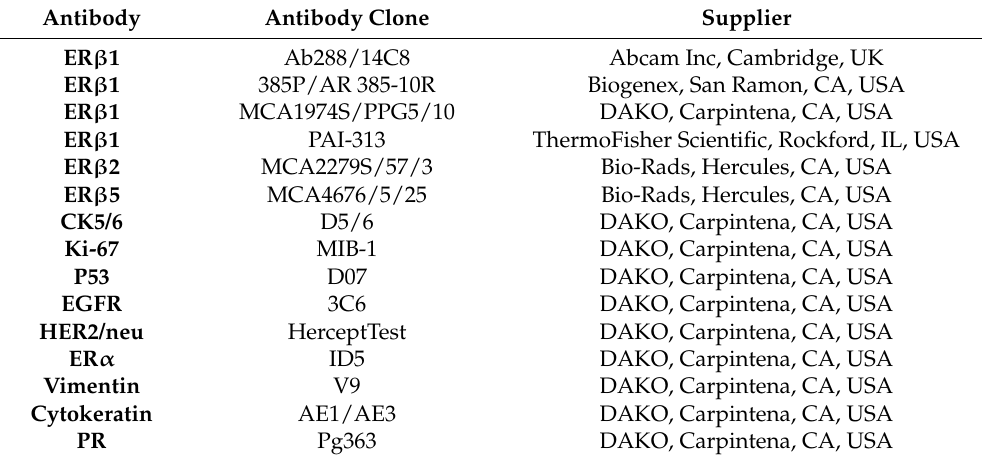
Table 1. List of antibodies used for